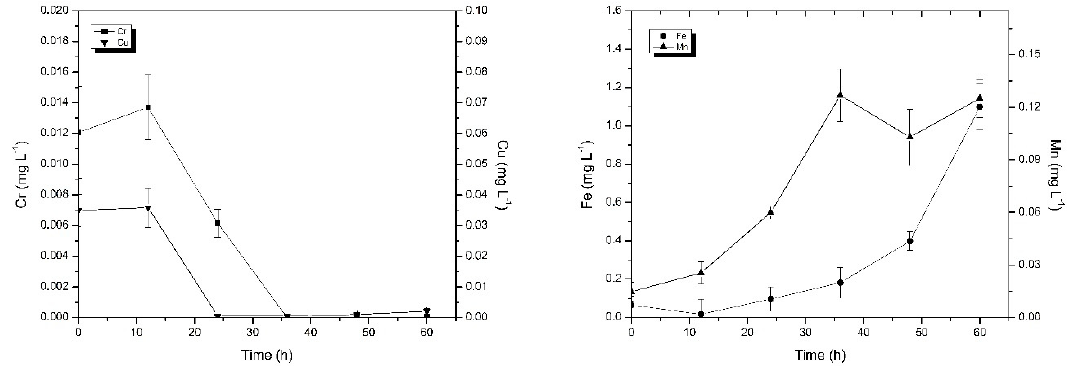
Figure 4. Change in copper, chromium, iron, and manganese mean concentrations in flowing water. Error bars indicate ± standard deviation. Table 3. Elemental composition of simulation corrosion scales (SCS) I by energy dispersive X-ray spectroscopy.